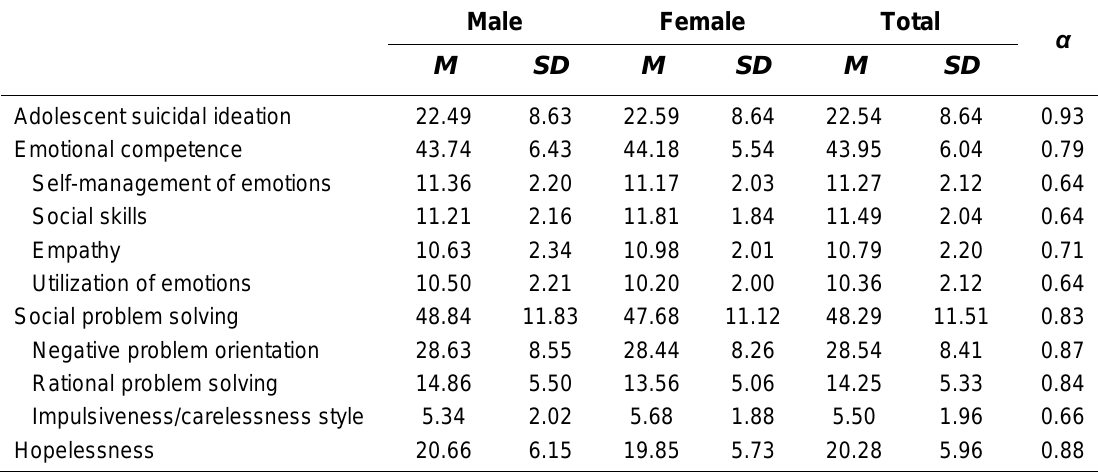
Correlations between Emotional Competence and Adolescent Suicidal Ideation Adolescent suicidal